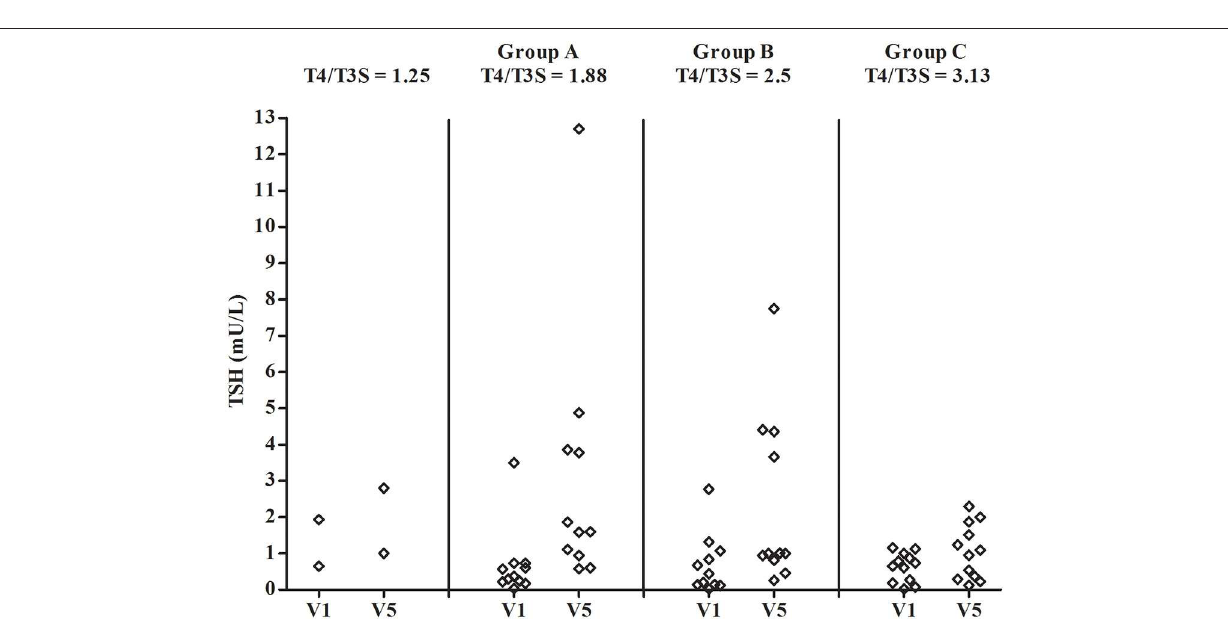
T3S (V5). The various groups are labeled according to the + 1.88, group B 2.5, group C 3.13. The 2 patients from group A and group B, who had to increase the T3S = = = =